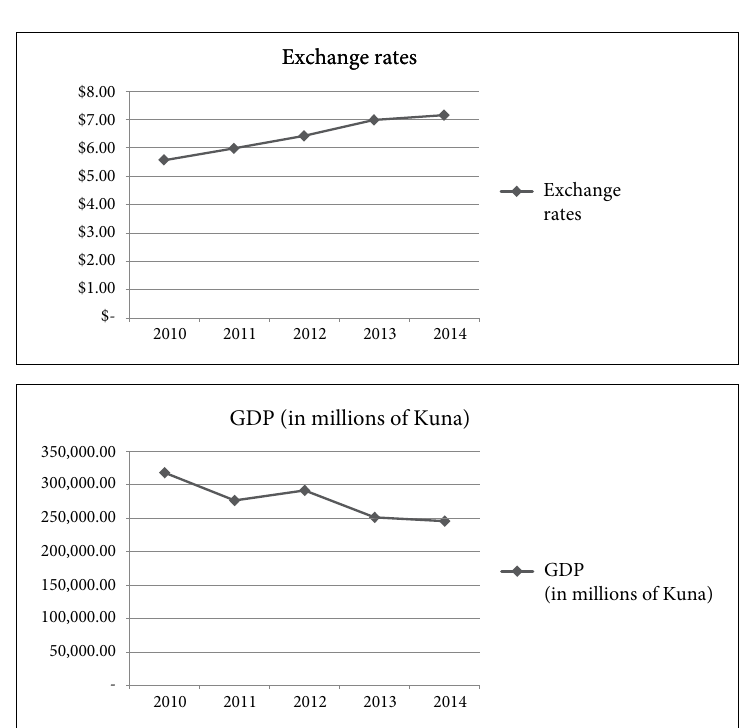
GDP (in millions of